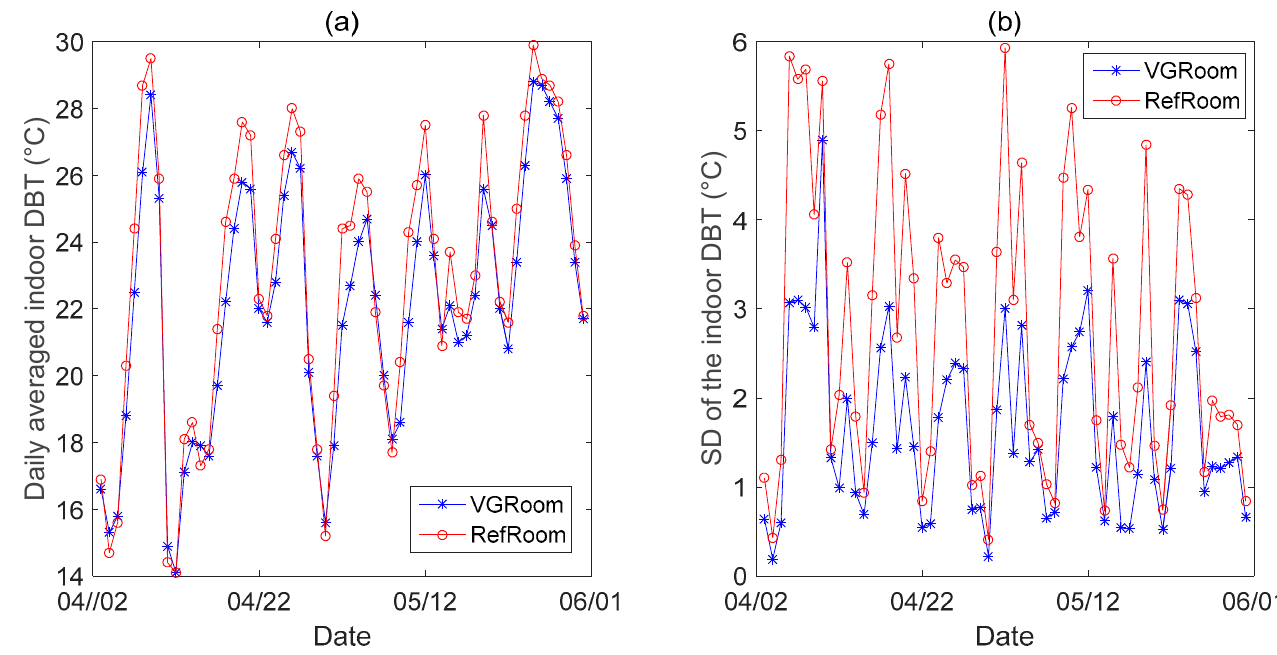
Figure 12. Daily averaged indoor DBT values ( a ) and their daily SD ( b ) during the experiment.